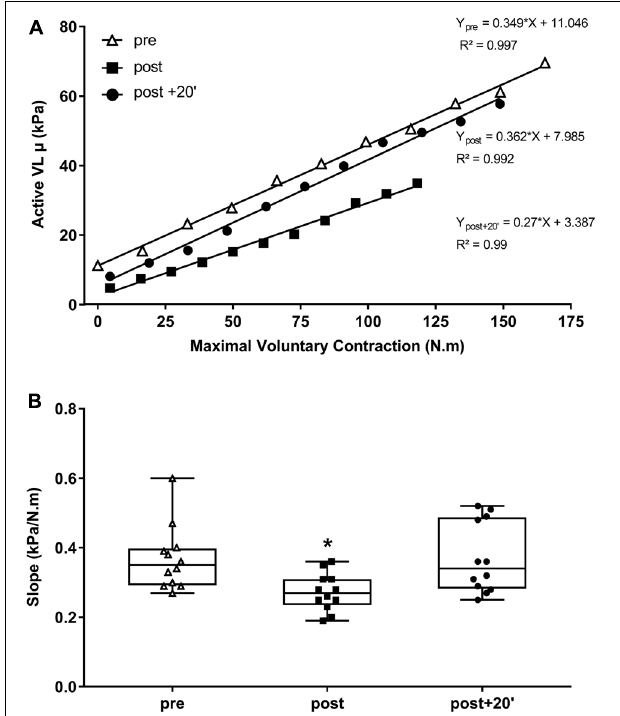
FIGURE 4 | Active vastus lateralis (VL) muscle shear modulus ( µ ) and absolute torque relationship of the knee extensor muscles evaluated before and after exercise and during the recovery period (post + 20’). Regression equations and correlation coefficients are presented for each relationship (A) . The mean of the slope for each time point and individual values are given (B) . Mean ± SD (B) . * P < 0.05, significant differences from pre-exercise (pre)